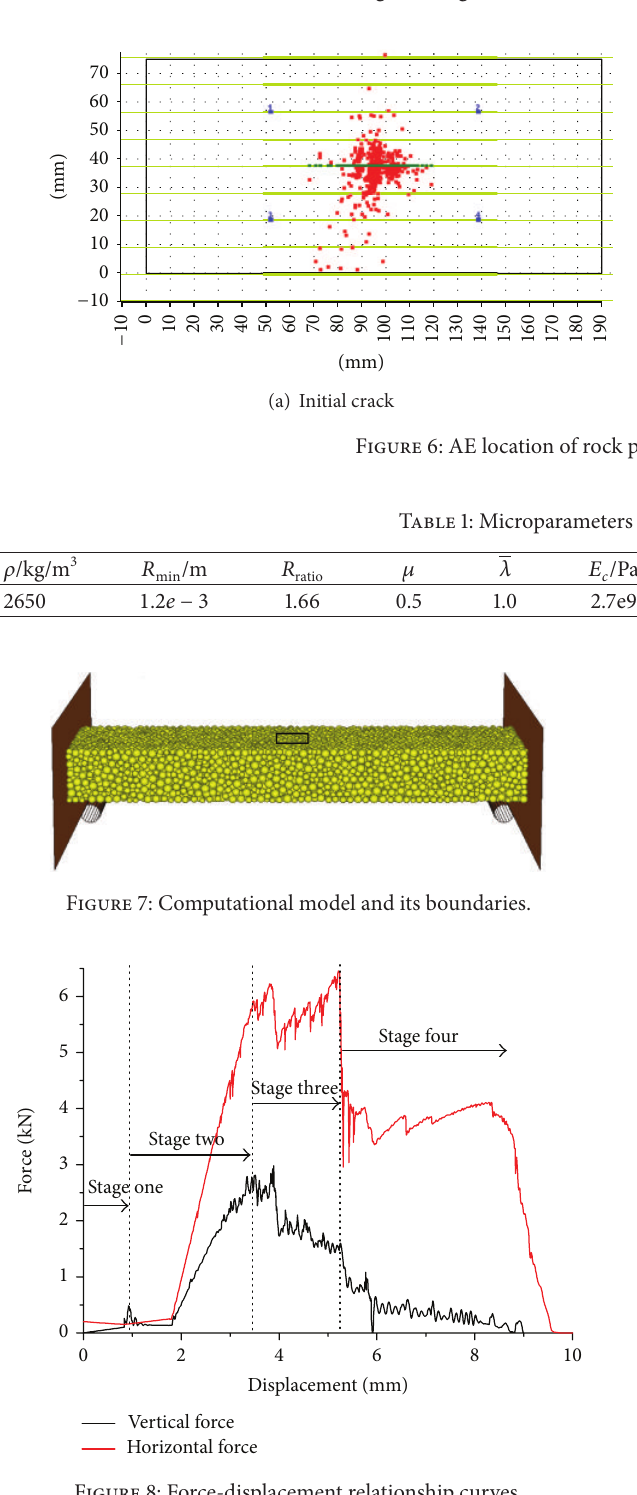
Figure 8: Force-displacement relationship